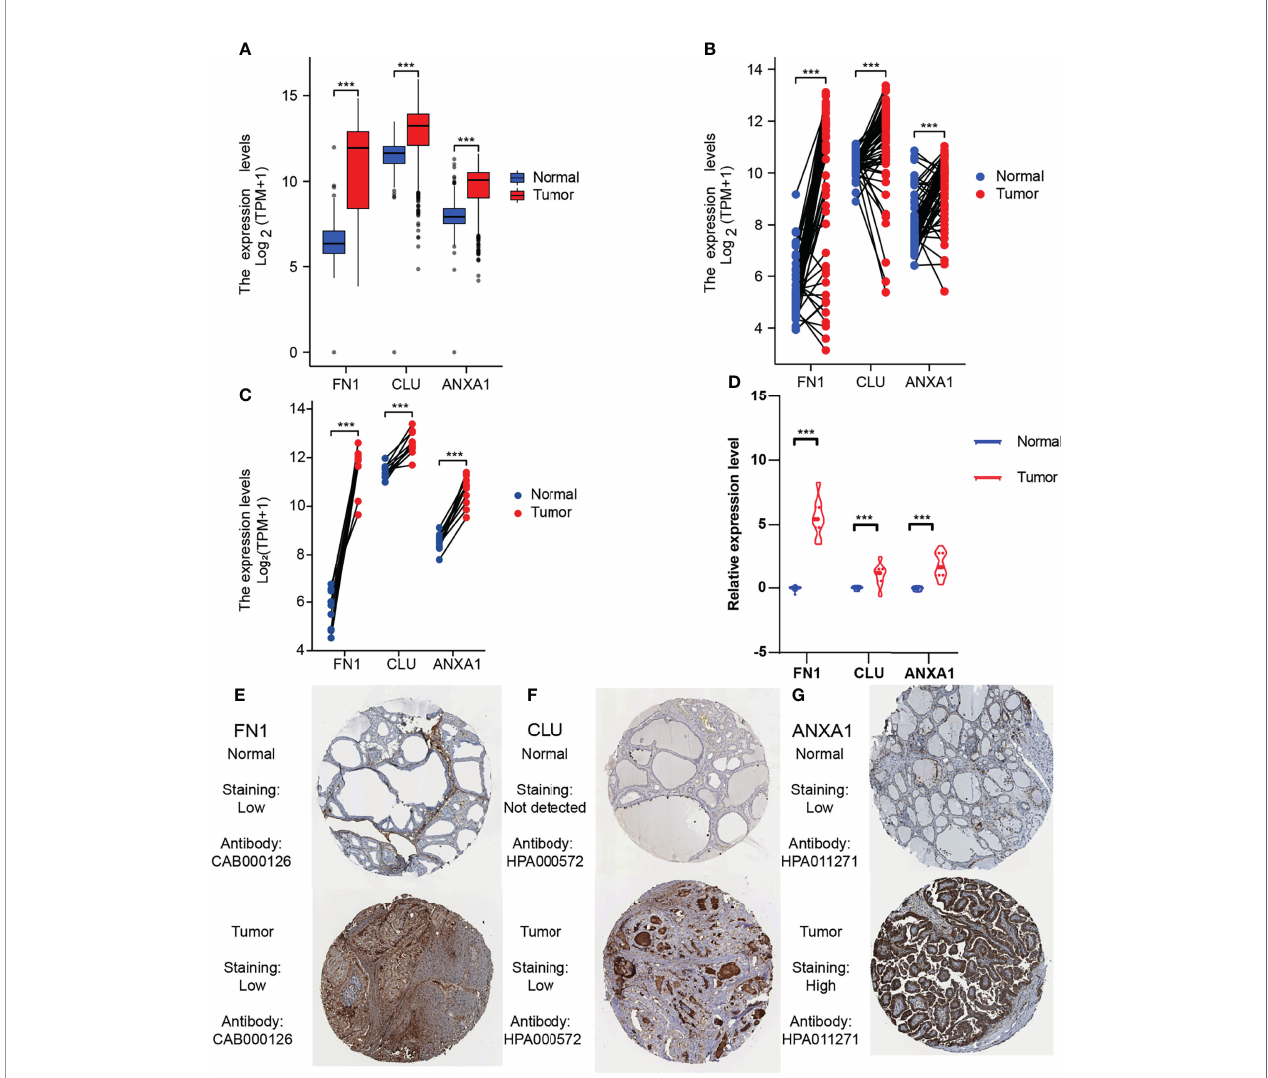
FIGURE 4 | Expression level of 3 prognostic related DEGs in THCA and our cohort. (A) Expression level of 3 DEGs in unpaired THCA samples. (B) Expression level of 3 DEGs in 58 paired THCA samples. (C) Expression level of 3 DEGs in our 10 paired bulk RNA-seq. (D) Relative expression level of 3 DEGs in our 20 paired samples (qRT-PCR). (E – G) The immunohistochemicalstaining degree of 3 DEGs in the THPA (Antibodies: CAB000126, HPA000572, and HPA011271). ***p ≤